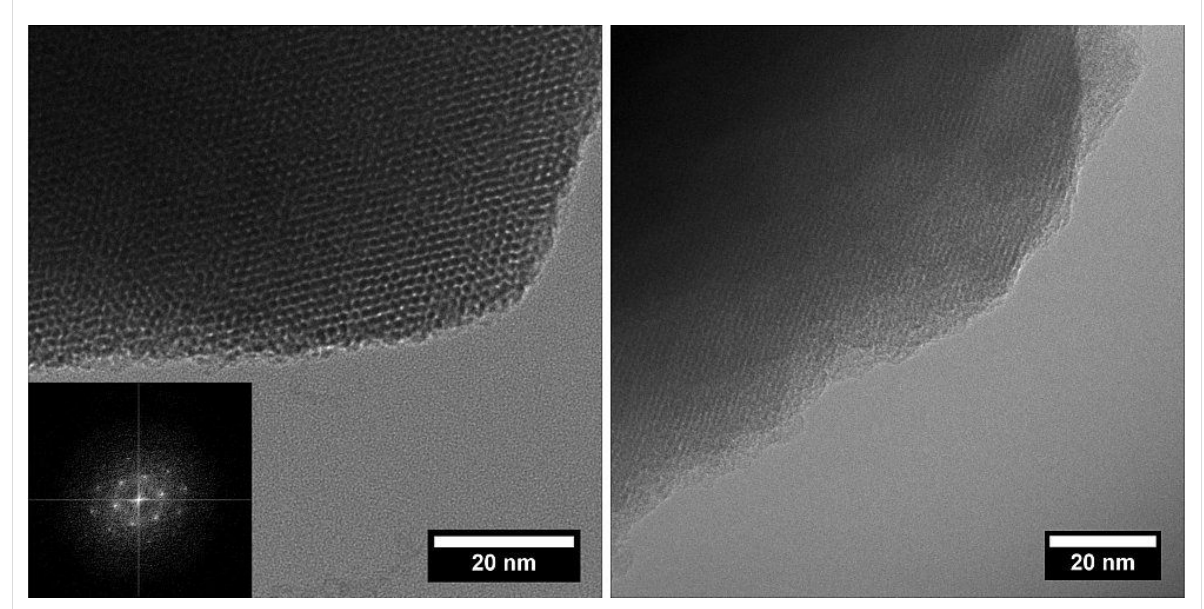
Figure 3: TEM images showing the mesoporous structure of MCM-ACR (left: frontal, right: lateral), inset in left image: Electron diffraction pattern.